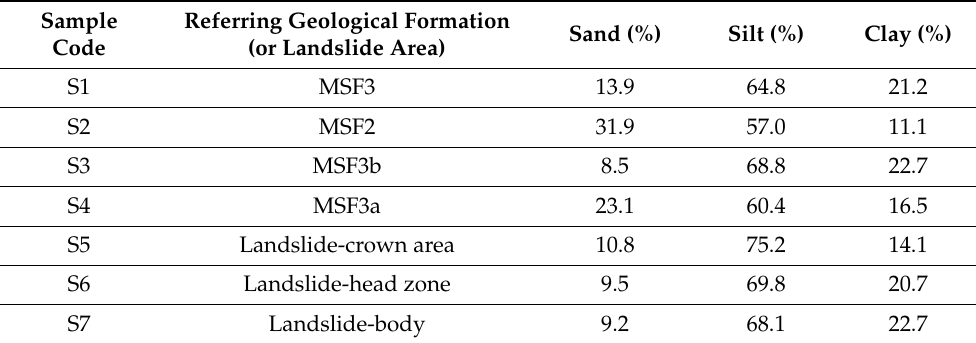
Table 2. Grain size distribution results of the seven samples (S1, S2, S3, S4, S5, S6, and S7) in the form of sand, silt and clay are reported as % in weight.